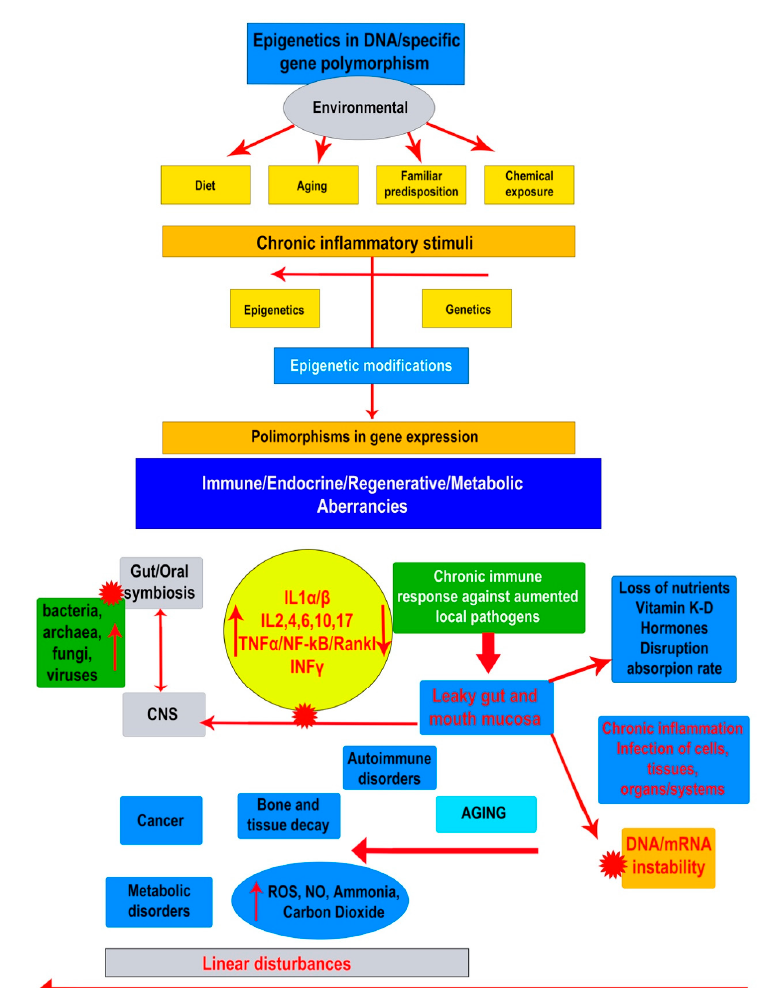
Figure 1. The proposed schematic representation of how the dysbiosis may eventually interfere the whole organism functionality. Environmental risk factors such as life style and food may negatively influence the microbiome raising up the activity of bacteria, fungi and viruses that lead the immune system towards a state of progressive pro-inflammatory activity through the presence of TNF-a, IFNy, Interleukins. Bidirectional signaling between the oral-gastrointestinal tract and central nervous system (CNS) occurs through spinal a ff erents demonstrate that these two systems showed some similarities in terms of expression of pro-inflammatory cytokines and altered physiological functions and have increased awareness about the epigenome and microbiome, highlighting a plausible link between the gut microbiome and epigenetic modification of the host. This has explained the intensification of various diseases such as immune-mediated, metabolic, and cardiovascular diseases and cancer. Two arrow head indicates e bidirectional communication between two systems.